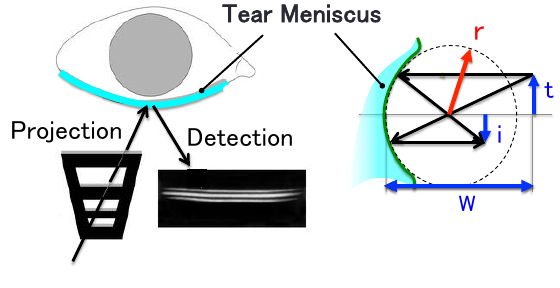
Figure 1. Diagram of meniscometry, edited image of